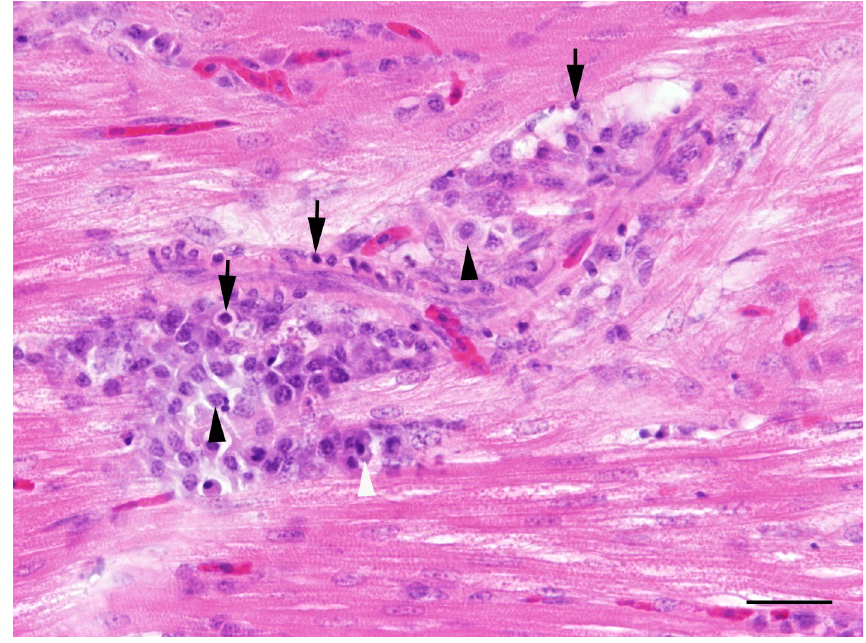
Fig 6. Pheasant chick with focal mild myocarditis characterised by infiltration of lymphocytes (arrows), macrophages (black arrowheads) and plasmacells (white arrowhead); HE, bar = 60 μ m.